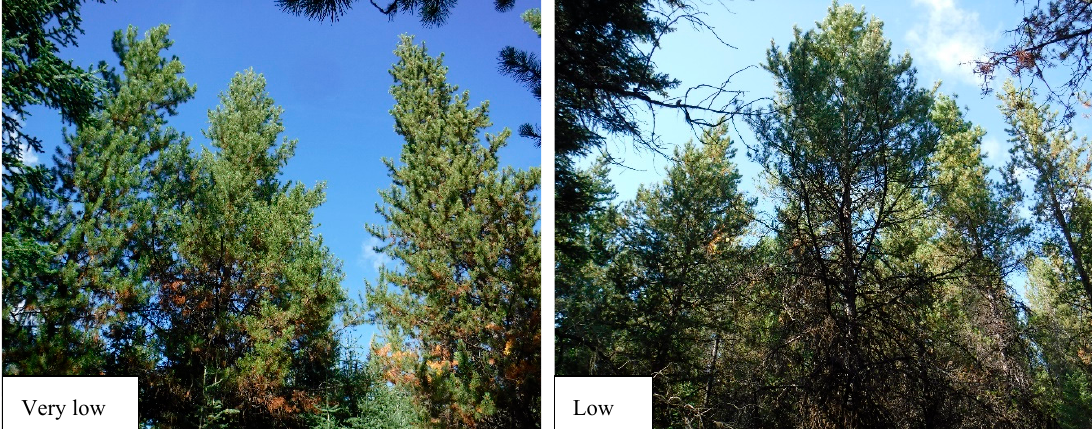
Figure 1. Photographs of lodgepole pine stands: four densities (stems/ha) of thinned, an unthinned stand, and an old-growth stand at Summerland in summer 2018, 25 years after initiation of treatments.